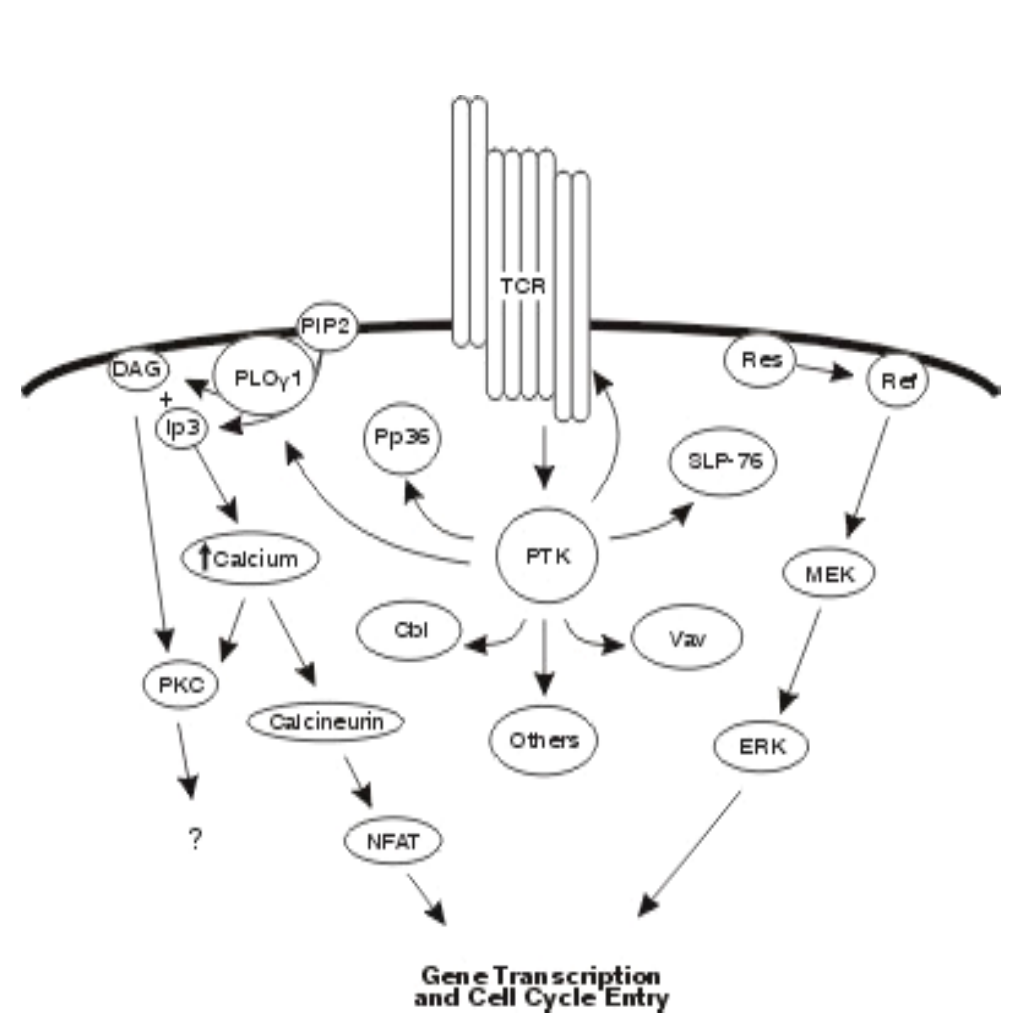
Figure 3: T-cell receptor signaling pathways - Protein tyrosine kinase activation couples the TCR to downstream signaling cascades. Activation of the phosphatidylinositol 2 nd messenger pathway follows the stimulation of phospholipase C-gamma-1 (PLC γ 1), which cleaves phosphatidylinositol 4,5-bisphosphate (PIP2) into diacylglycerol (DAG) and inositol triphosphate (IP3). IP3 induces the release of intracellular calcium stores and the activation of calcium sensitive enzymes. Calcineurin is a Ca2 + -dependent serine/threonine phosphatase that dephosphorylates the cytosolic form of nuclear factor of activated T cells (NFAT), resulting in its nuclear translocation and activation of gene transcription through the NFAT response element. Protein kinase C (PKC) activation by DAG and calcium flux results in the serine/threonine phosphorylation of PKC substrates. Ras activation results in the recruitment of Raf to the plasma membrane, which activates the dual specific serine tyrosine kinase MEK, which in turn activates ERK, a member of the MAP kinase family. Activated ERK phosphorylates transcription factors that, along with other TCR-induced transcription factors, activate the transcription of new genes; Vav, Cbl, SLP-76, pp36, and “others” are shown as molecules that may link PTK activation to distal signaling pathways